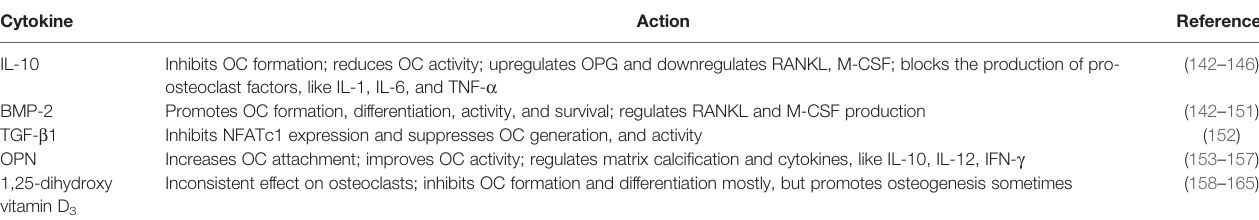
TABLE 2 | Summary of the effects of cytokines produced by M2 macrophage on osteoclasts.